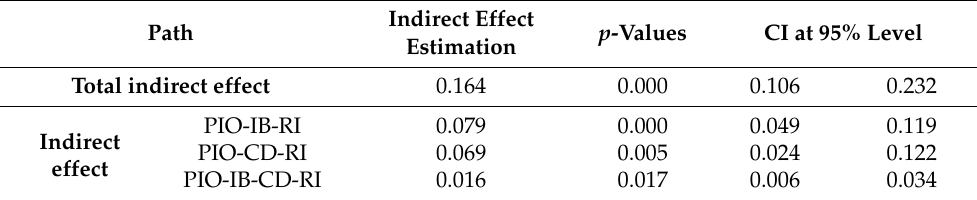
Figure 2. Estimation of model. Note: *** p < 0.01. Table 5. Mediating effect and 95% confidence interval estimated by Bootstrap method.